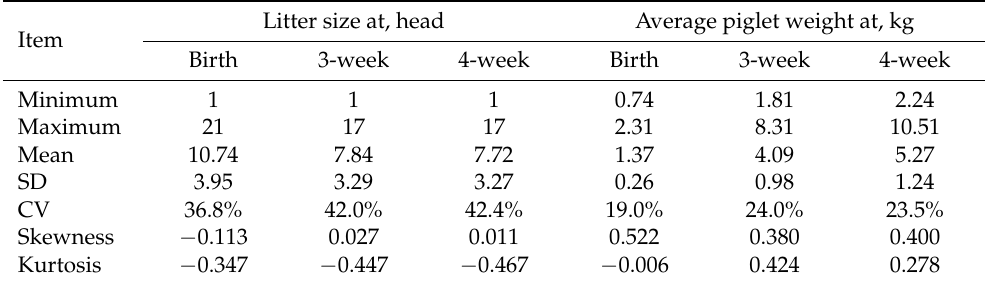
Table 1. Descriptive summary for litter sizes and average piglet weights from birth to weaning in KHAPS Black